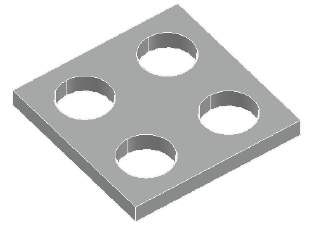
Figure 4. Base plate.